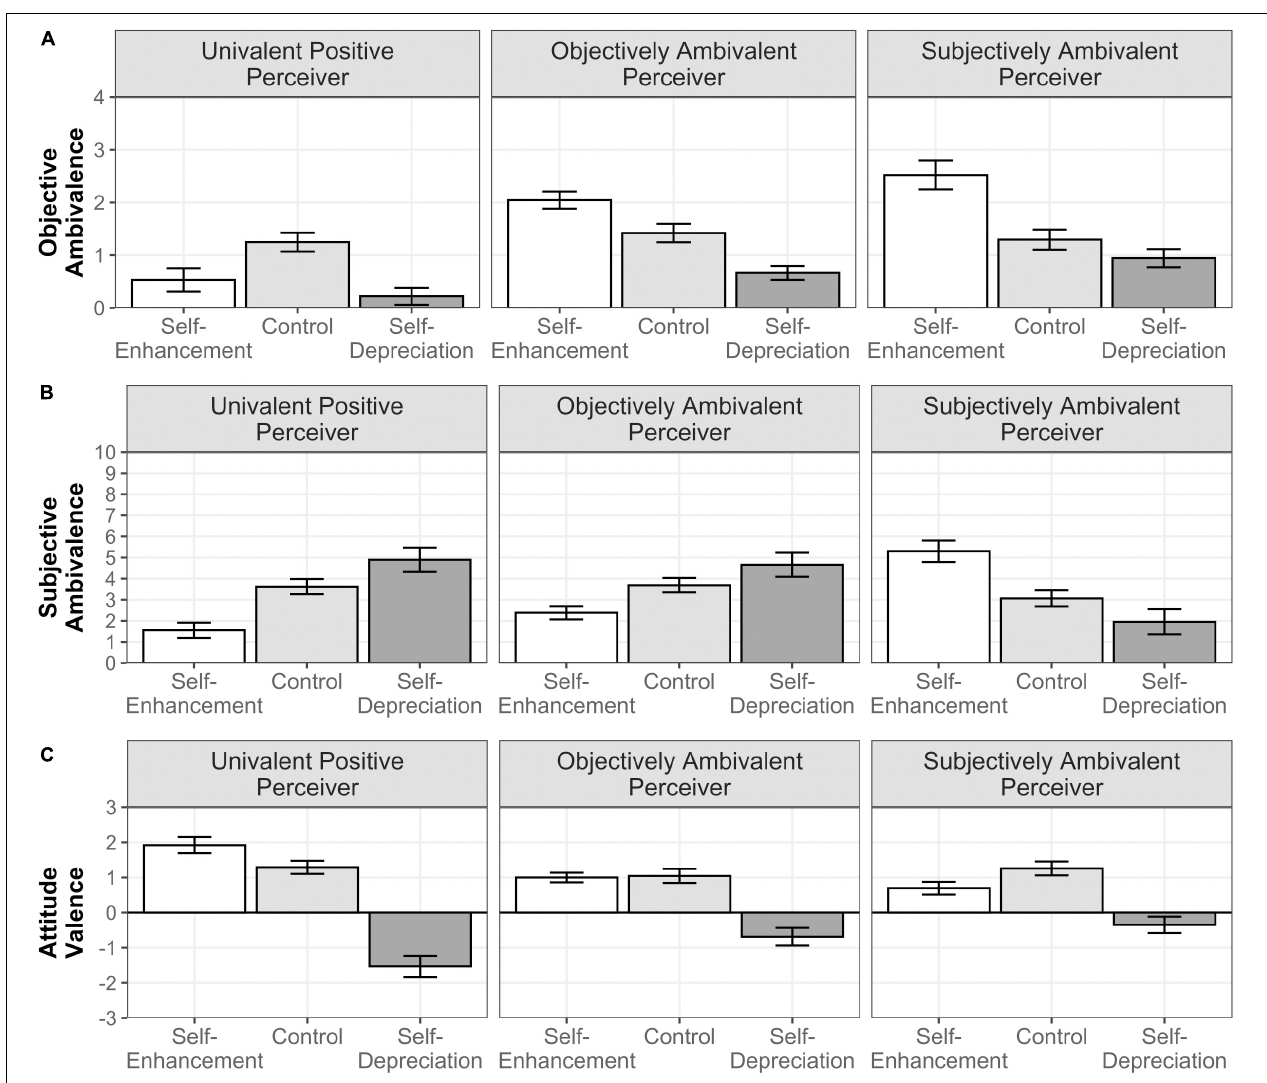
FIGURE 1 | Moderated influence of self-presentation instructions by the perceiver’s attitudinal profile on reported OA (A) , SA (B) , and attitude valence (C) in Study 1. Error bars represent 95% CIs.